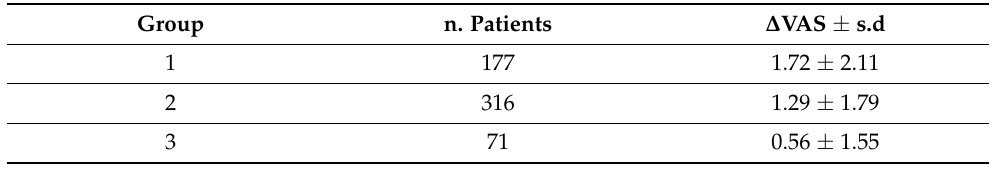
Table 3. Average ∆ VAS of patient groups constituted on the basis of the number of favourable alleles for pain decrease after treatment with cannabis.